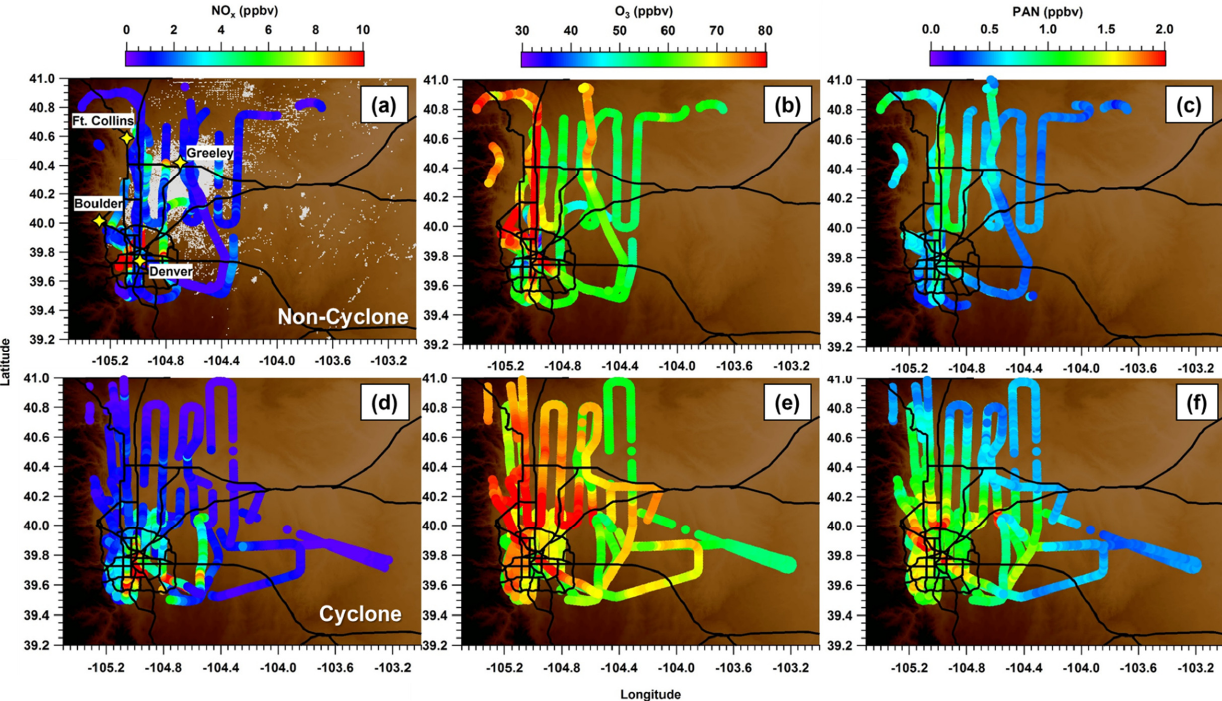
Figure 5. Spatial distribution maps along the C130 flight track of NO x [NO + NO 2 ], ozone (O 3 ), and peroxyacetylnitrate (PAN) in the Colorado Front Range during the non-cyclone (a–c) and cyclone episodes (d–f) . Major highways are shown with black lines, and grey markers in (a) represent the location of active oil and gas wells in the region with data available from the Colorado Oil and Gas Conservative